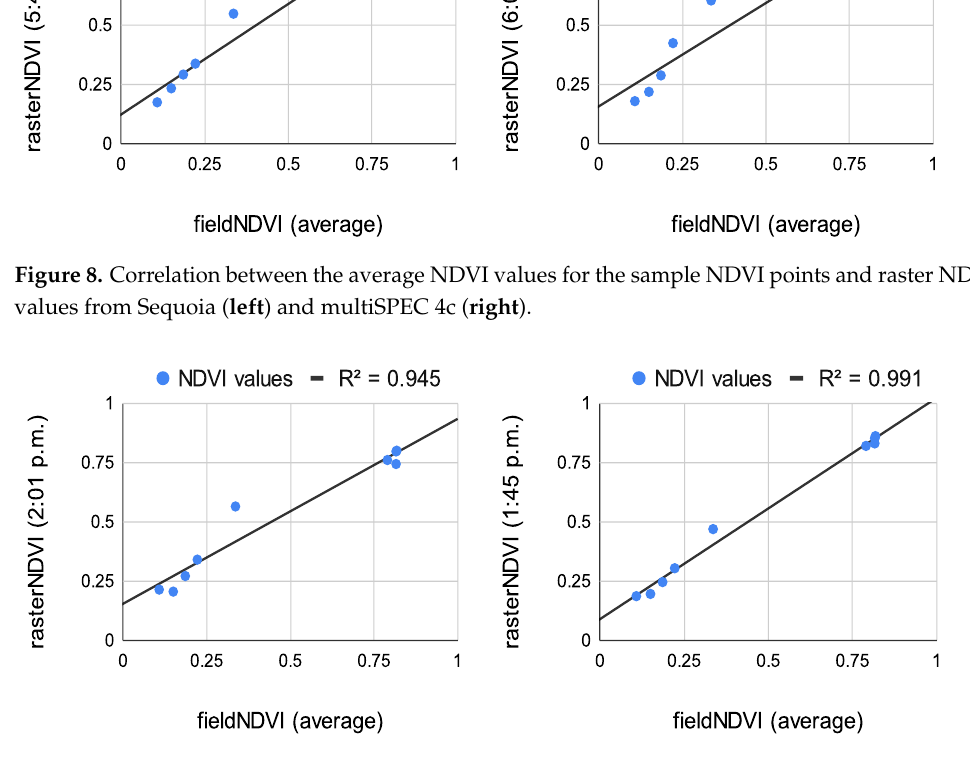
Figure 9. Correlation between the average NDVI values for the sample NDVI points and raster NDVI values from Sequoia ( left ) and multiSPEC 4c ( right ).